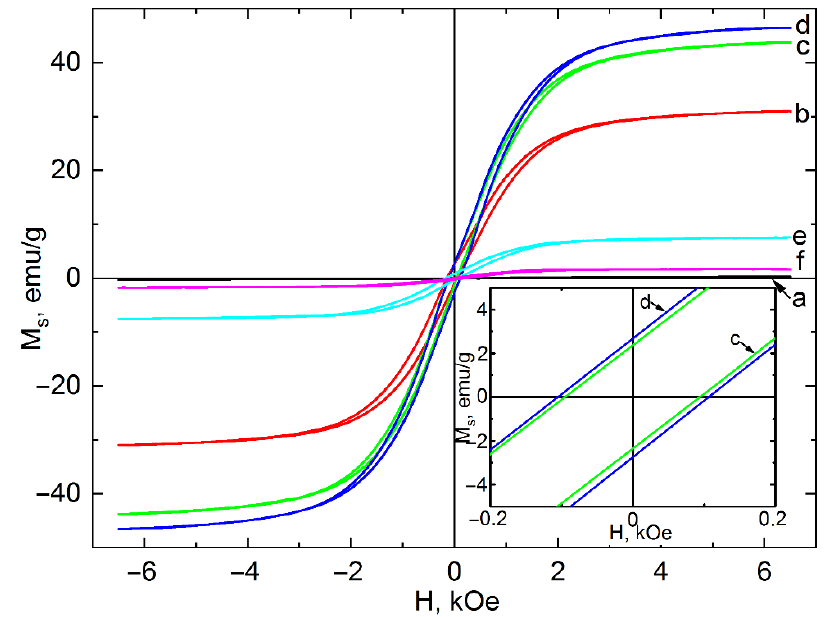
Figure 7. Hysteresis loops of samples after 3 ( a ), 6 ( b ), 9 ( c ), 12 ( d ), 18 ( e ), and 24 h ( f ) of synthesis. Based on obtained results and the mechanism suggested by Lian et al. [27], the pos- sible pathway of reaction during ANPs formation was proposed. While the observed chemical processes during ANP synthesis are in general agreement with the reactions described in the Materials and Methods section, some differences are observed. A scheme of the proceeding stages is presented in Figure 8. Since magnetite ANPs is obtained by the co-precipitation of iron salt in two oxidation states, the solubility of formed hydrox- ides (oxyhydroxides) should be taken into account for the determination of reaction routes. Since the solubility product of Fe(OH) 3 (K sp (Fe(OH) 3 ) = 2.79∙10 −3 9 ) is much smaller than that of Fe(OH) 2 (K sp (Fe(OH) 2 ) = 4.87∙10 −1 7 ) [55], Fe(OH) 3 is the first to be precipitated during the reaction. As one of the condensed aqua-hydroxo complexes, Fe(OH) 3 is known not to exist in solution in such a form [56]. At first, hydrolysis of FeCl 3 is accompanied by the formation of β -FeOOH nano- ellipsoids (including dehydration of iron hydroxide) that act as a template for the further synthesis of ANPs (Figures 2a and 3a). Thus, this process can be considered as a shape- determining stage. Predominant formation of β -FeOOH at the earliest stages is due to the stabilization of its structure by Cl − ions incorporating into the tunnels located in it structure (Figure 8a) [57]. The initial concentration of FeCl 3 affects the size of β -FeOOH nanoellipsoids [58]. For this reason, it should be taken into account when synthesizing ANPs of a specified shape and size.